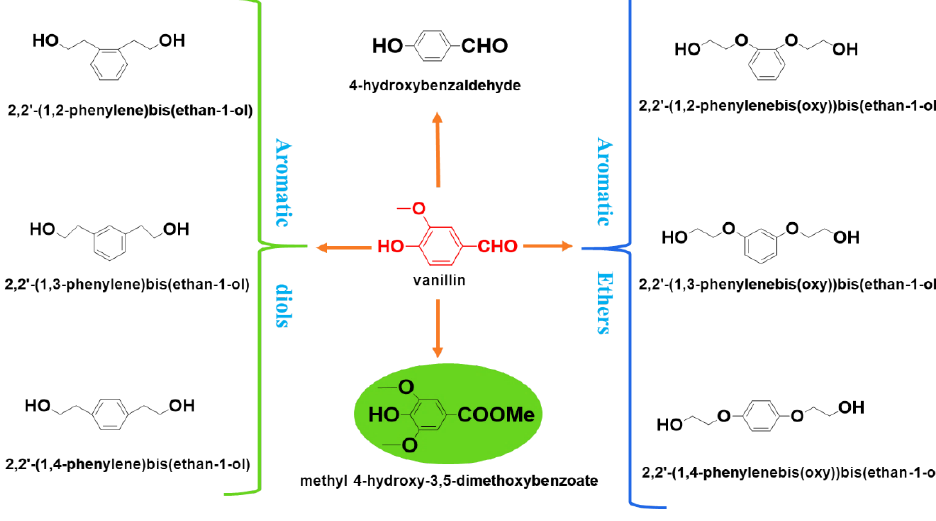
Figure 2. Bio-sourced monomers extracted from lignin.